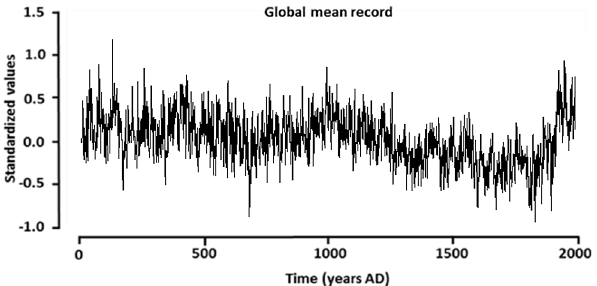
Figure 3. Global Arctic mean record obtained from the paleocli- mate series contained in the PAGES Arctic 2k